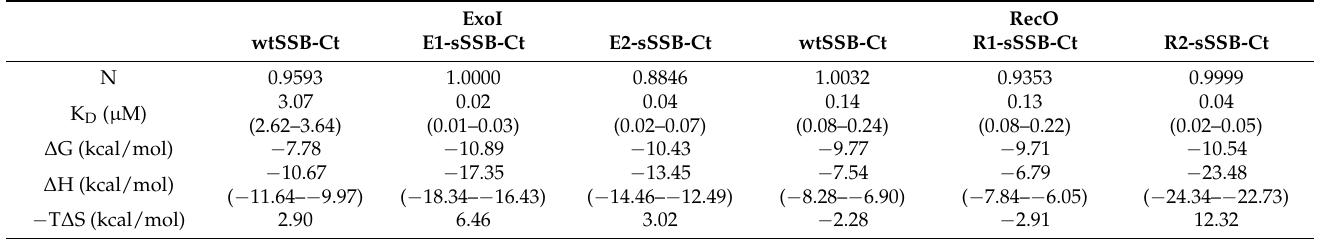
Table 3. Thermodynamic parameters obtained from the ITC binding data for the interactions of wtSSB-Ct variants with ExoI and RecO. Confidence intervals are shown for KD and ∆ H values. ExoI RecO